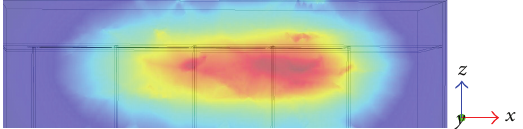
Figure 5: SAR distribution calculated on the surface of the area to be treated. The color bar here is the same as in Figure